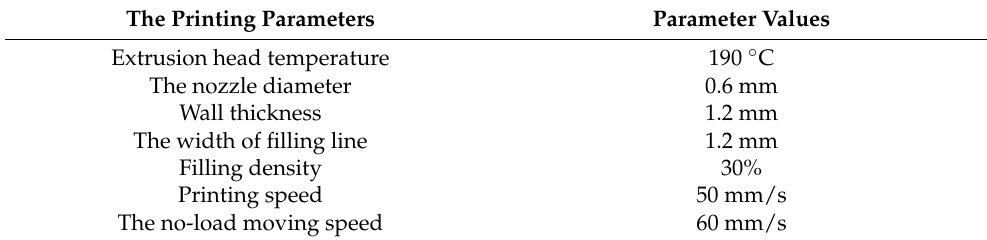
Table 1. Basic parameters of filling and printing.